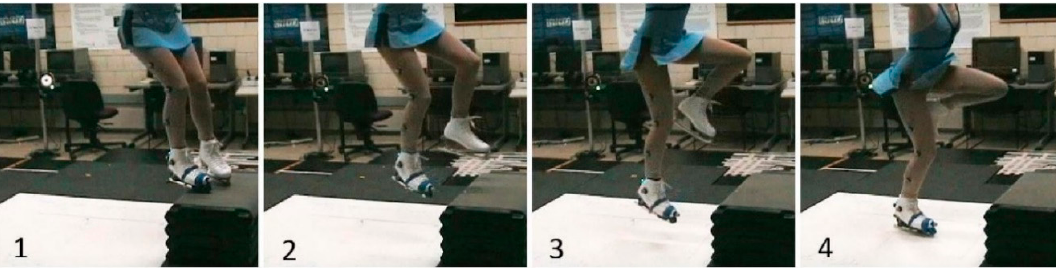
Figure 2. Force plate validation setup. Skaters performed drop landings from a box onto two force plates covered with HDPE artificial ice. Time progresses from left (1) to right (4).